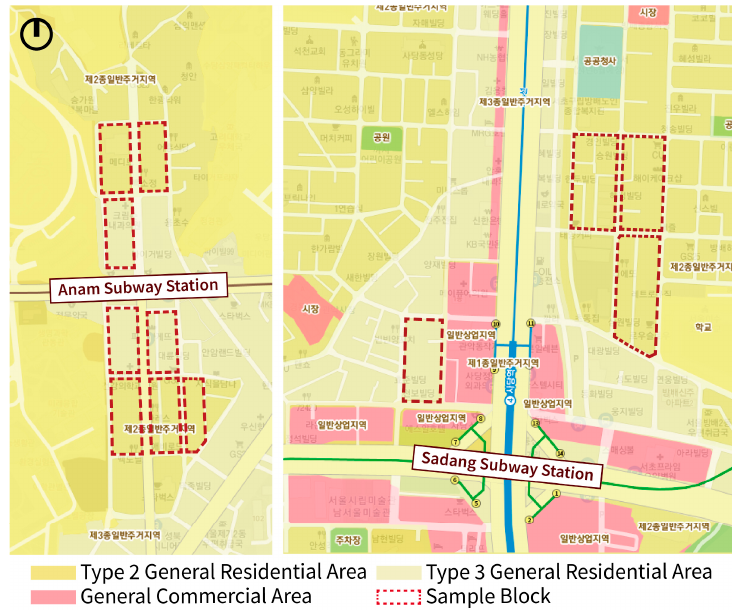
Figure 5. Research block location and adjacent neighborhood map.